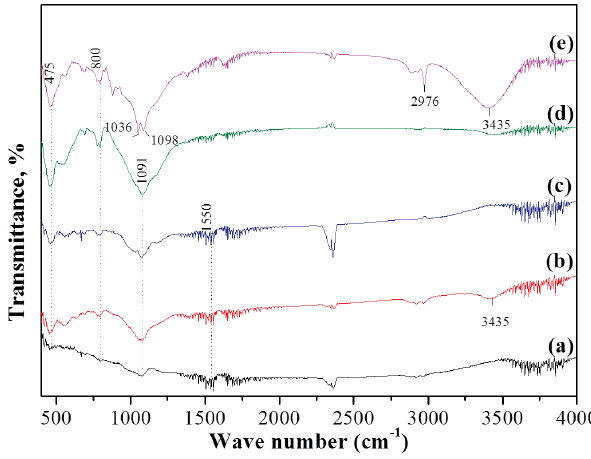
Figure 2. FTIR spectra of (a) uncalcined Fe 3 O 4 -HBC composite, (b) 400 6 C under air, (c) 400 6 C under nitrogen, (d) 1000 6 C under air, (e) 1000 6 C under nitrogen.